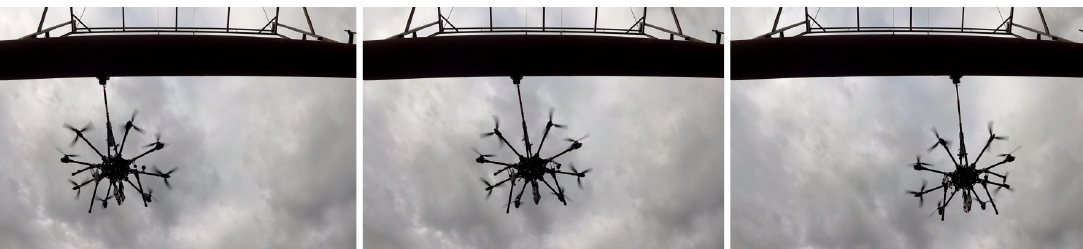
Figure 9. AeroX during contact flight in an experiment performed in Seville in October 2018. AeroX was flying in autonomous mode and the end-effector was teleoperated by the inspector. Images at different times show the motion of the end-effector along the pipe while keeping the relative position of the aerial